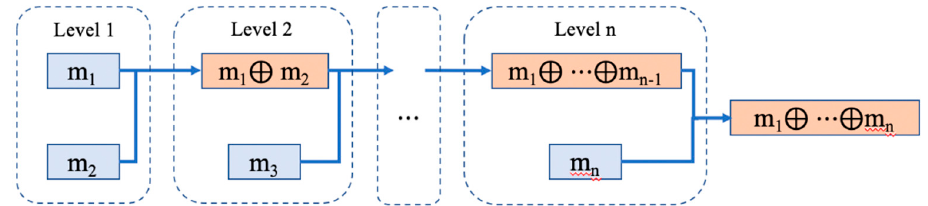
Figure 6. Fusion Figure 6. Fusion structure.